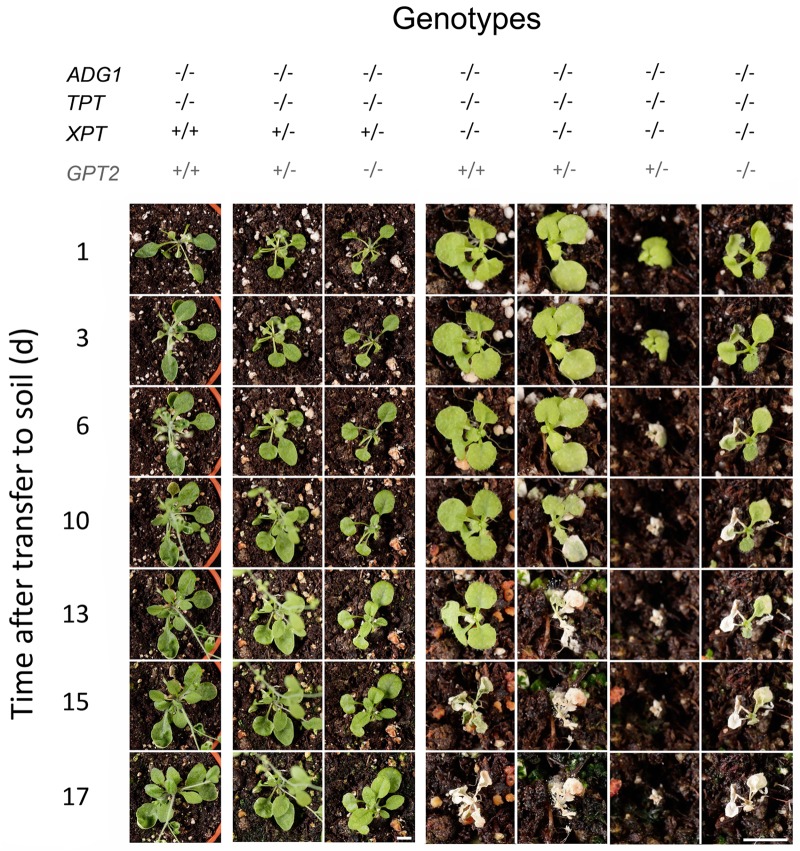
Time course of phenotype developments after transferring members of a segregating mutant population defective in ADG1, TPT, XPT and GPT2 to soil. Plants were grown for 28 days on 1/2MS agar plates supplemented with 50 mM Suc and then were transferred to soil for the time indicated. The homozygous deficiency of the XPT in the adg1-1/tpt-2 background led to the death of the plants between days 6 and 15 after transfer to soil (left panel), whereas genotypes with a homozygous defect in ADG1 and TPT, but a wild type or a heterozygously affected XPT survived on soil (left and central panel). Note the different size of the space bars (representing 1.0 cm) for the right panel and the left/central panel. In all cases plants were grown under long-day conditions at a PFD of 150 μmol⋅m-2⋅s-1. The zygosity of GPT2 is shaded in gray because it does not contribute to the overall phenotype.